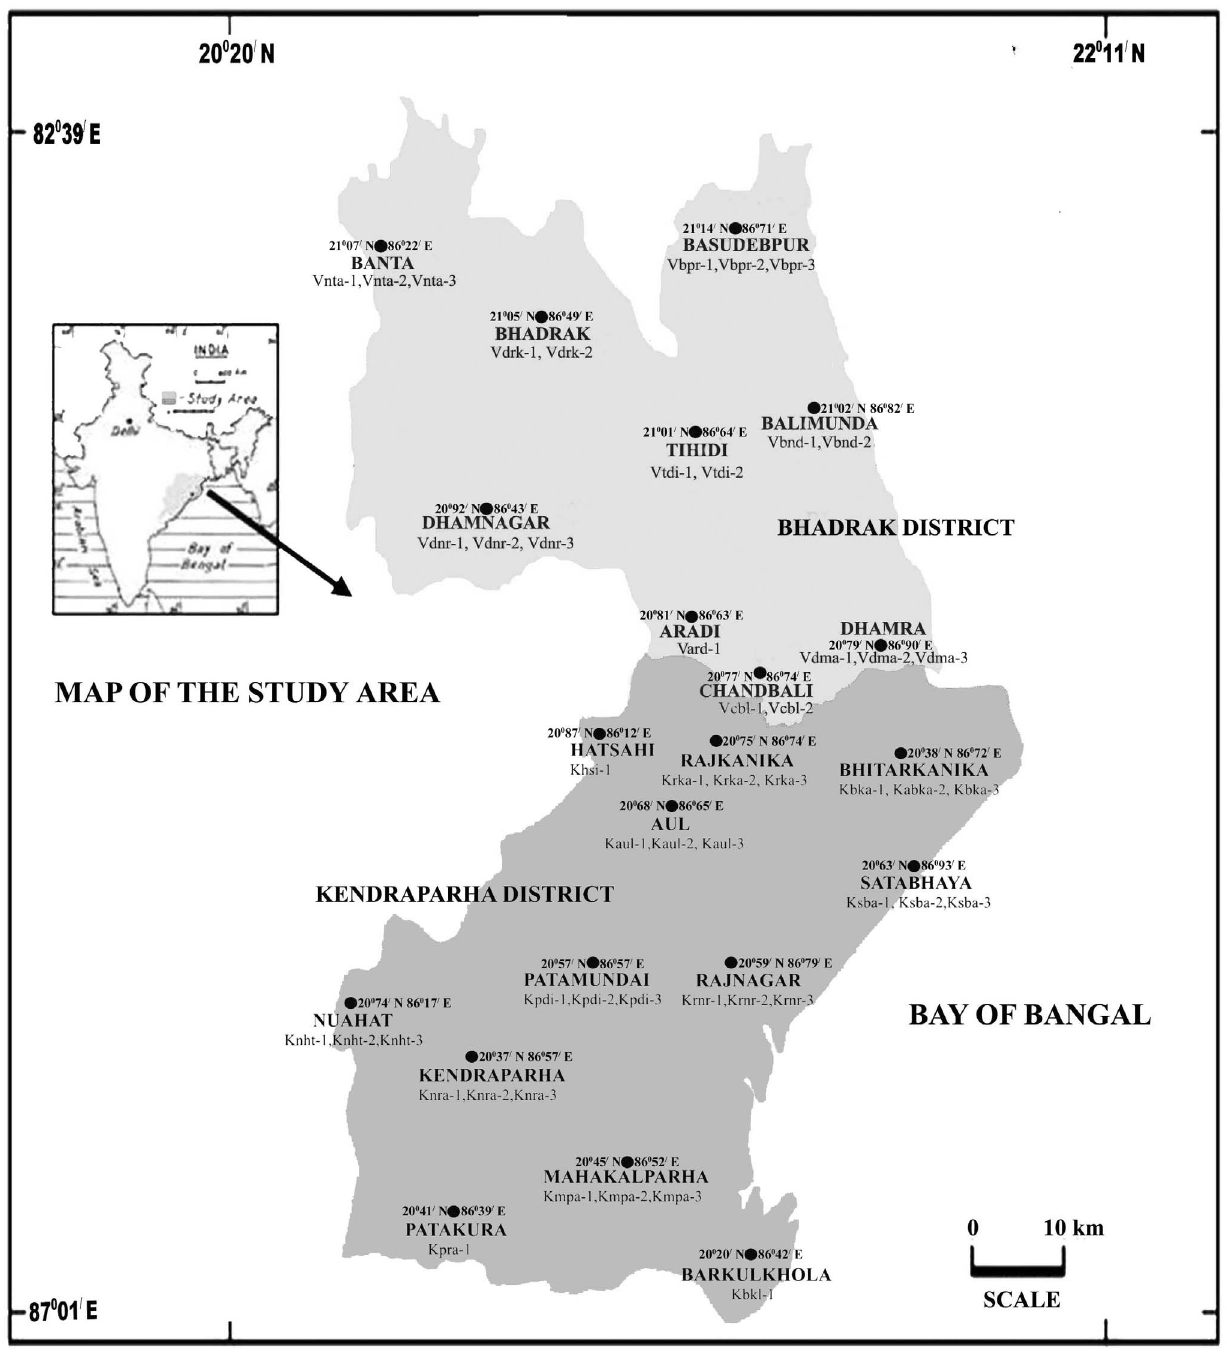
Figure 1. Location Map of study areas in the coastal districts of Orissa, India. Latitudes and longitudes of each study area and honey sample numbers have been mentioned.